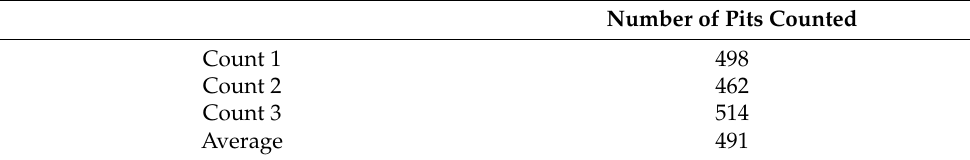
Table 2. Number of pits